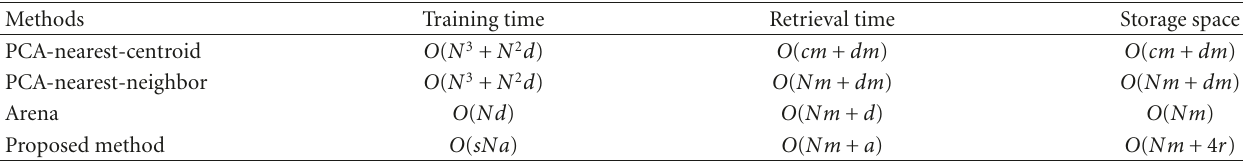
Table 9: Comparison of asymptotic behavior between the proposed method against ARENA and PCA-based techniques.